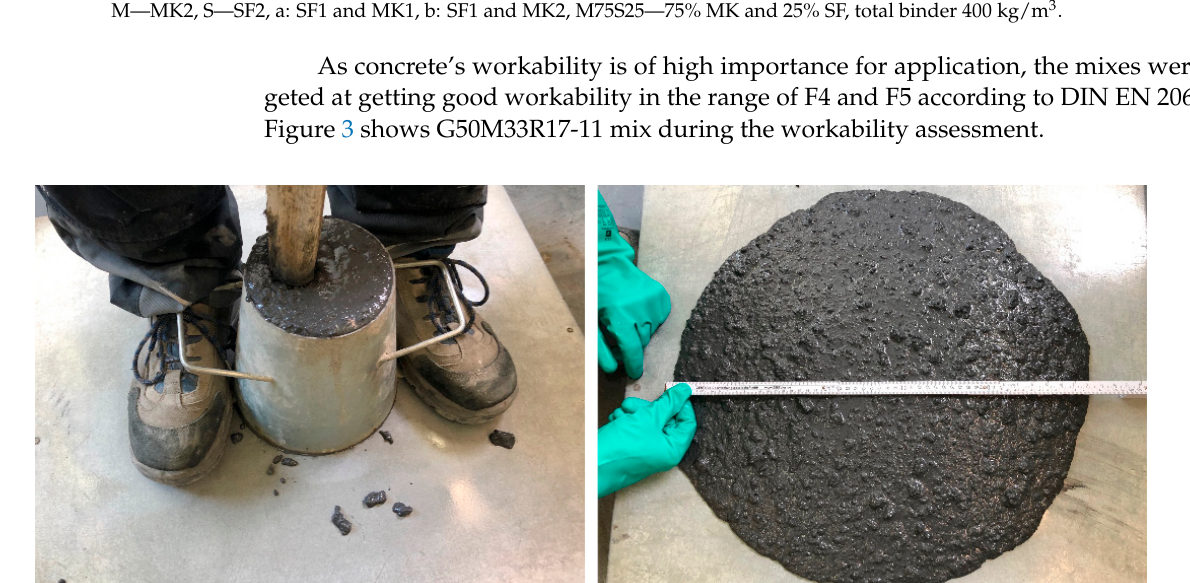
Table 4. Details of mix proportions and results for MK ‐ based concretes.